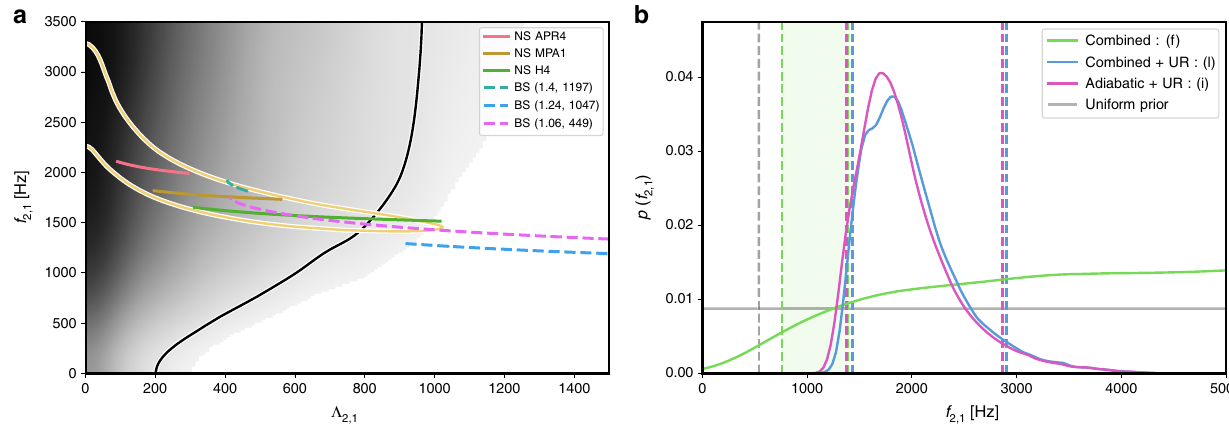
Fig. 1 Results for the larger-mass object of GW170817. a The black shaded region shows the two-dimensional probability distribution function (PDF) for the f 2 -mode frequency and quadrupolar tidal deformability of the larger companion Λ 2,1 , where the subscripts denote the multipolar index ℓ = 2 and the larger mass object's label A = 1. The solid lines correspond to the 90% credible regions, where the black curve corresponds to the analysis in which f 2,A are treated as independent parameters and the yellow one to imposing the universal relations, i.e., fi xing f 2,A given Λ 2,A . The posteriors are overlaid with UR predictions for three EoS for NSs (coloured solid curves), and three massive BSs (coloured dashed curves) denoted ( m b / m n , λ b ), with m n = 1.675 × 10 − 27 kg being the neutron mass, where all curves are restricted to the 90% interval of the component mass posterior, m 1 ∈ [1.37, 1.63] M ⊙ . b Marginalised one- dimensional PDF for the f 2 -mode frequency. We show results for the following three tidal phase models as listed in Table 1: (i) purely adiabatic tides with URs imposed (pink), (l) adiabatic and dynamical tides with UR imposed (blue) and (f) adiabatic and dynamical tides without UR assumed (green). The dashed lines indicate the corresponding 90% lower bound (green) for the UR-independent analysis or credible interval (pink and blue) for the results with the UR imposed. The green shaded region indicates how the lower bound changes in the UR-independent analysis when a different upper limit on the prior for Ω 2,A , ranging between 0.182 and 0.5, is